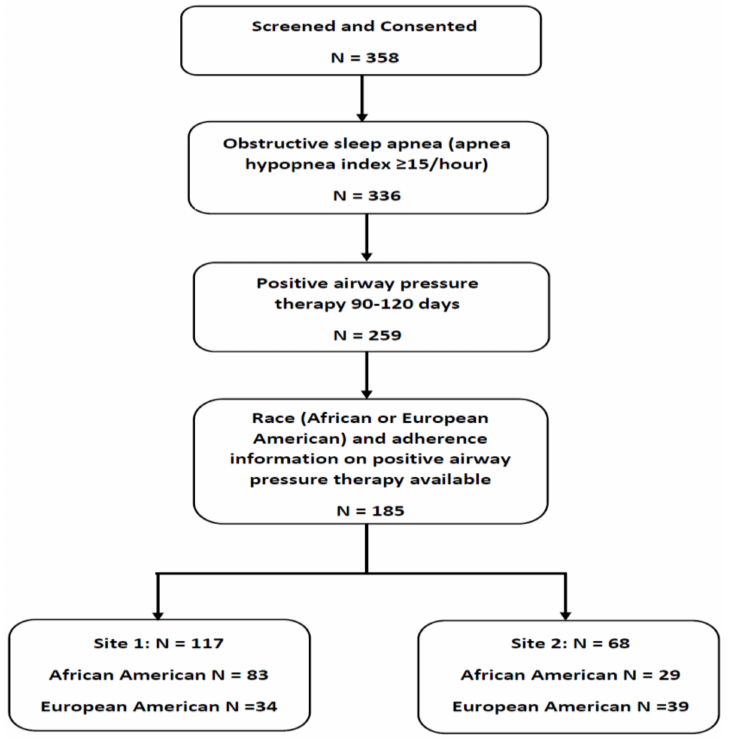
Figure 1. Flow diagram of study sample. Table 1. Baseline